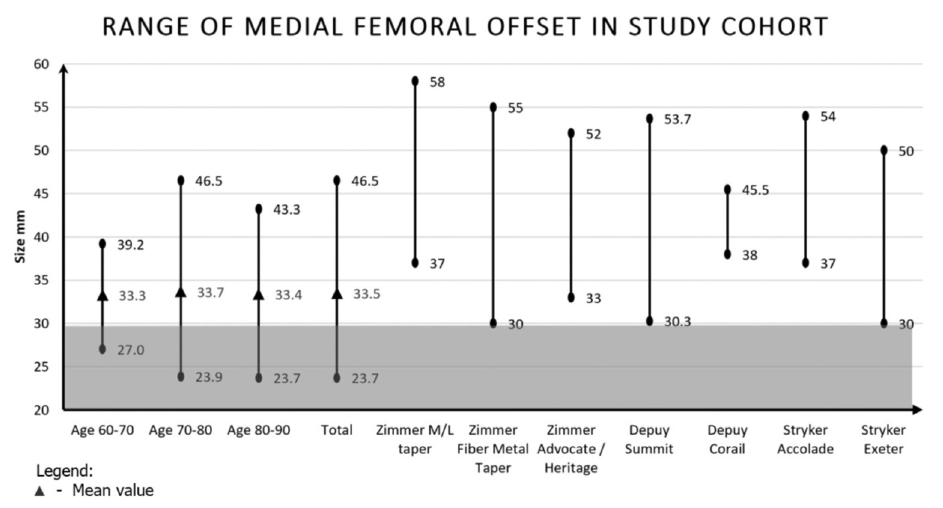
Range of medial femoral offset in study cohort. Legend: Mean Fig. 4: